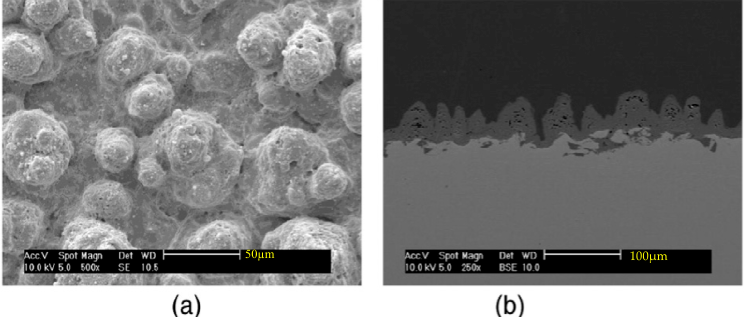
Figure 10. SEM images at the ( a ) surface and ( b ) cross-section of HA coating from low concentration solution showing a dome-like microstructure. Reproduced with permission from [39], Elsevier, 2017.